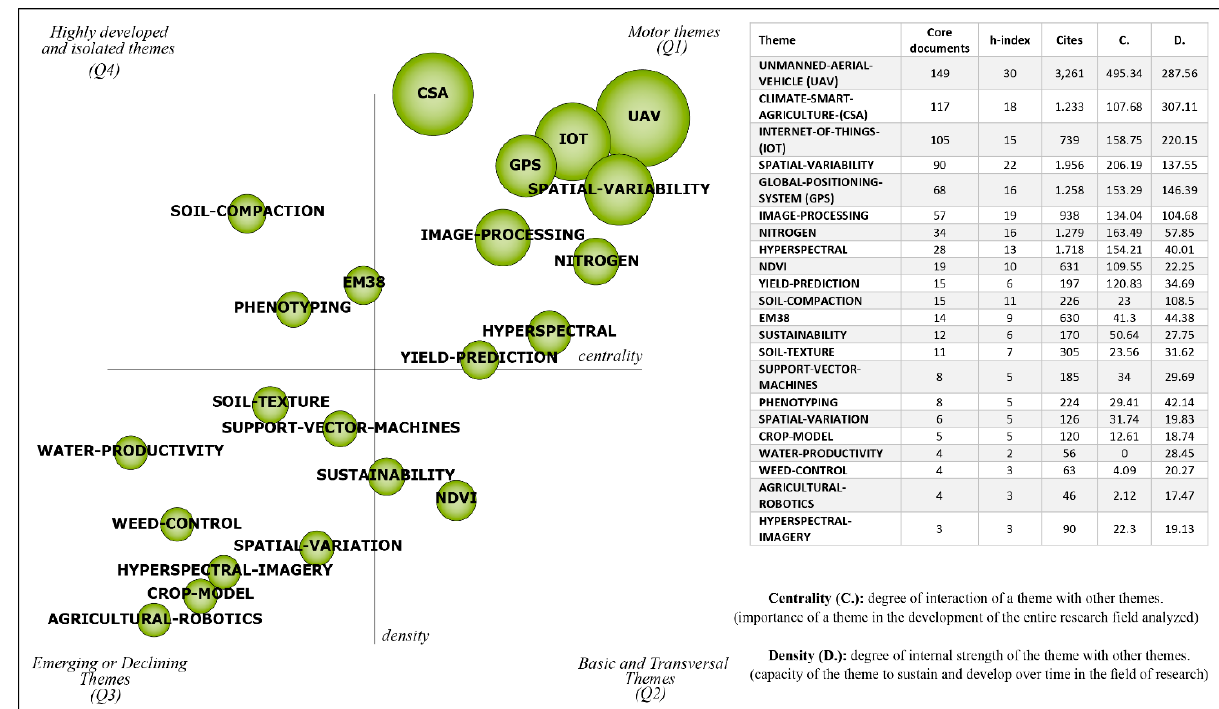
Figure 3. Strategic diagram and performance analysis.